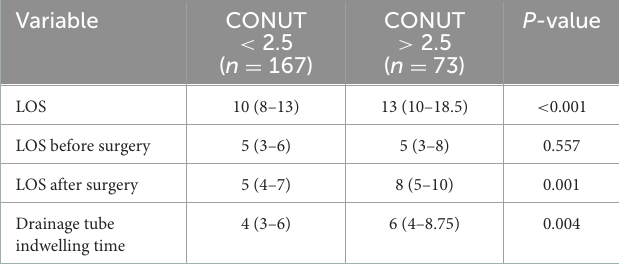
TABLE 5 Relationship of CONUT score with length of hospital stay and drainage tube removal time.